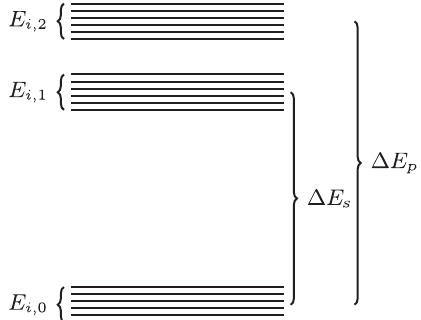
FIG. 2. Schematic representation of the spectrum for Hamil- tonians of form Eq. (1) which are considered. The gaps high- lighted are the spin gap Δ E and pairing energy Δ E . Notably, s p the spin gap and pairing energy are approximated as independent of small variations in